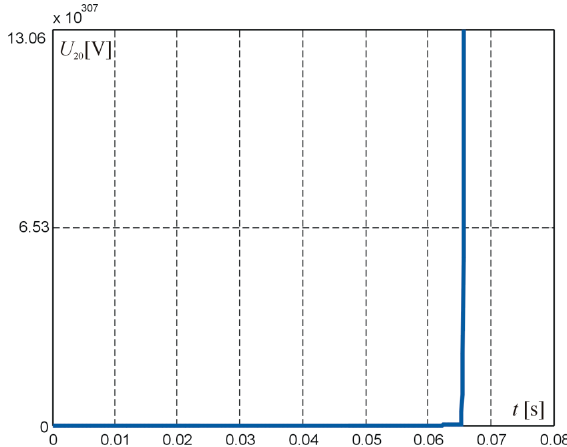
Figure 7. Digital simulation of the solution for Equation (12).